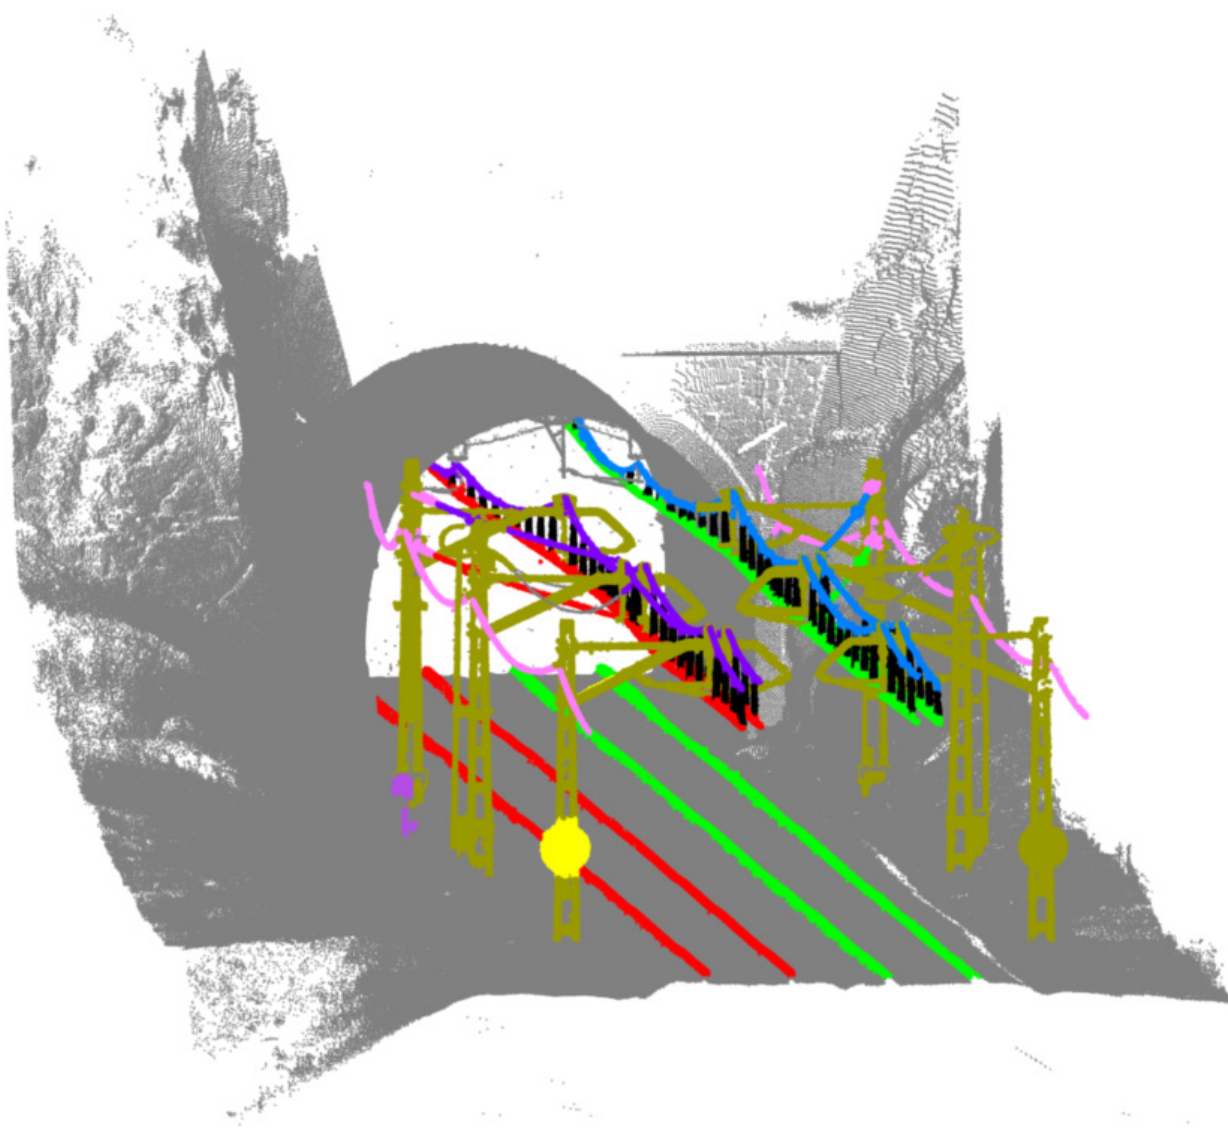
Figure A3. Tunnel entrance segmentation: masts are represented in gold colour. Each contact wire has a different colour (green and red), matched by its correspondent rail. Each catenary has also a random colour. Other wires are coloured in pink, droppers in black, and marks in magenta.